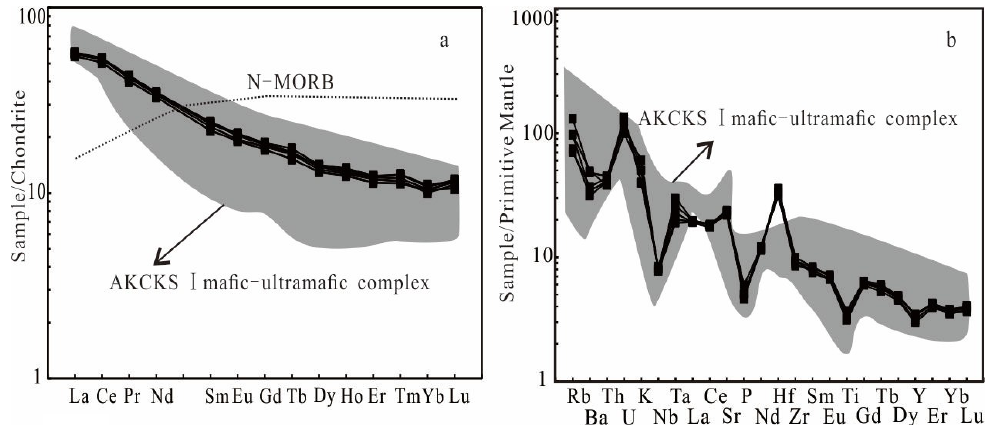
Figure 5. ( a ) Chondrite-normalized rare-earth elements (REE) patterns (after Boynton [21]) and ( b ) primitive-mantle-normalized spider diagrams (after McDonough and Sun [22]) for gabbros from the Akechukesai IV mafic–ultramafic complex. Gray shadow areas are from a compilation of literature data.